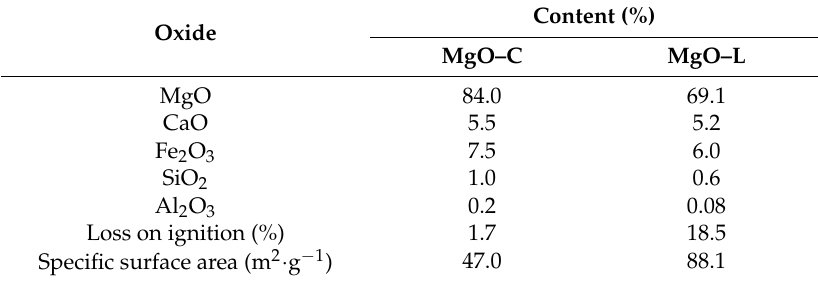
Figure 1. Comparison of samples: natural magnesite ( a ), MgO – L ( b ) and MgO – C ( c ) of the mean particle diameter of 1031 µ m, 385 µ m, and 337 µ m. Table 1. Chemical composition of MgO products and specific surface area.